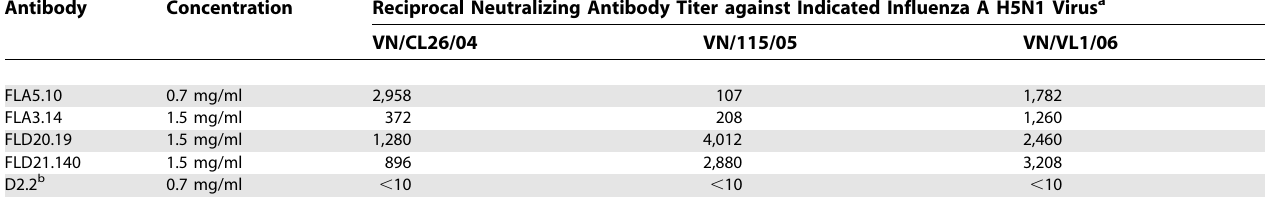
Table 1. Neutralizing Titers of mAbs against Influenza A H5N1 Influenza Viruses Isolated from Viet Nam Antibody